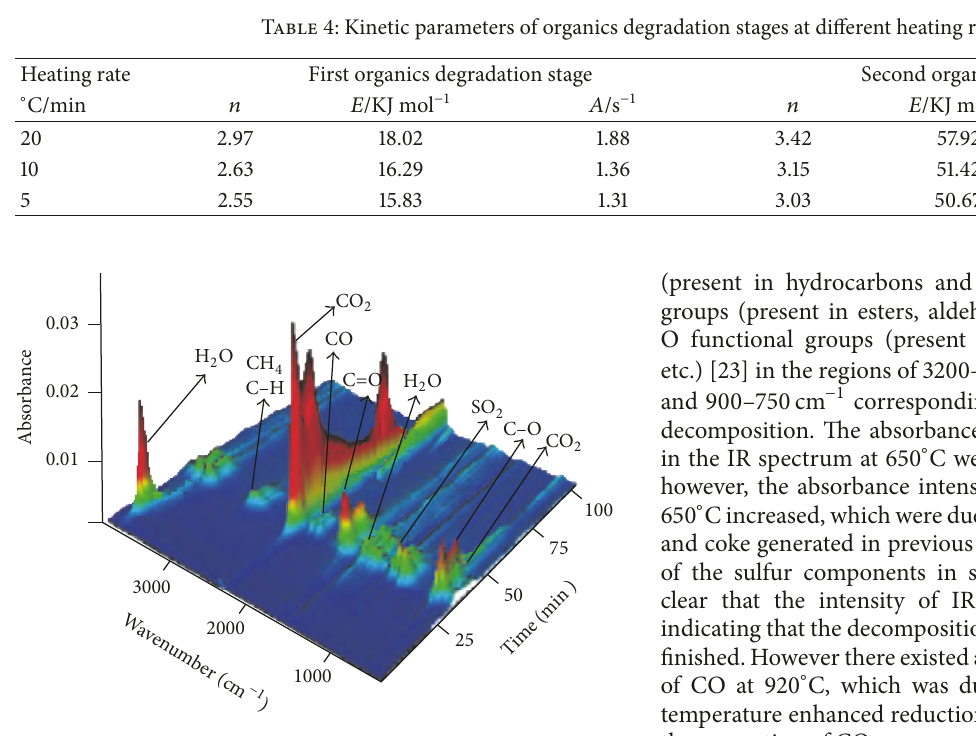
Figure 4: Three-dimensional FTIR of gaseous products obtained from sediment pyrolysis.